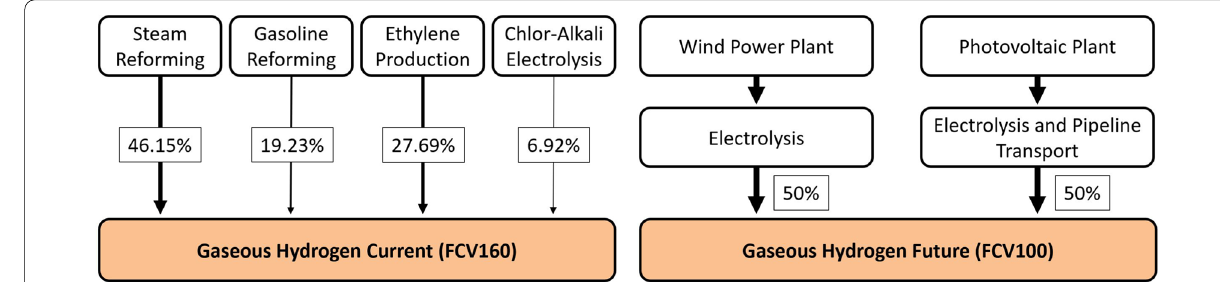
Fig. 4 Composition of current Gaseous Hydrogen (FCEV160) and future Gaseous Hydrogen (FCEV100) Production